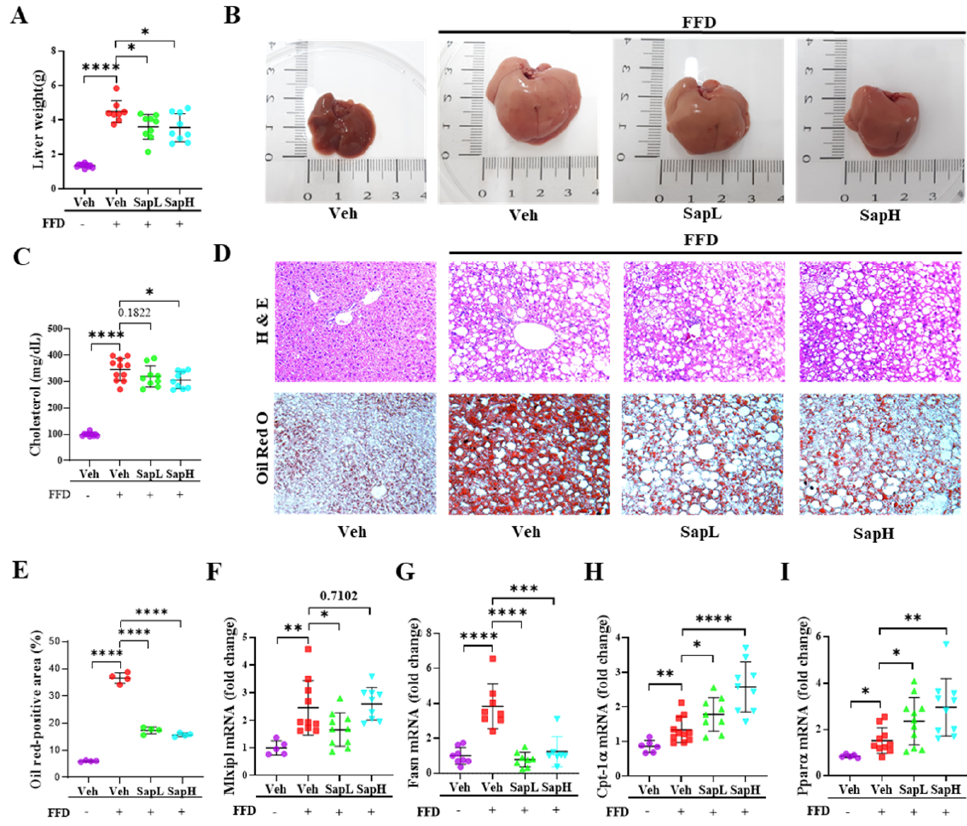
Figure 1. Saponin extract improved the fast food diet (FFD)-induced hepatic steatosis in vivo. Saponin extract was orally administered to mice for the last 9 weeks until the animals were sacrificed. ( A ) Liver weight gain was measured in the last week. ( B ) The appearance of the liver. ( C ) The level of cholesterol in the serum was measured. ( D ) Representative images of liver pathology, with H&E staining and Oil Red O staining; images were acquired at original magnification and 400×; scale bars, 20 µm. ( E ) The quantification of the Oil red positive area. Expression of ( F ) Mlxipl, ( G ) Fasn, ( H ) Cpt-1α, and ( I ) Pparα in liver tissue were measured by qRT-PCR and shown as folded changes compared with normal diet mice. Relative mRNA expression levels were normalized to mouse glyceraldehyde 3-phosphate dehydrogenase (GAPDH) levels. The data are expressed as means ± sem. * p < 0.05, ** p < 0.01, *** p < 0.001, and **** p <